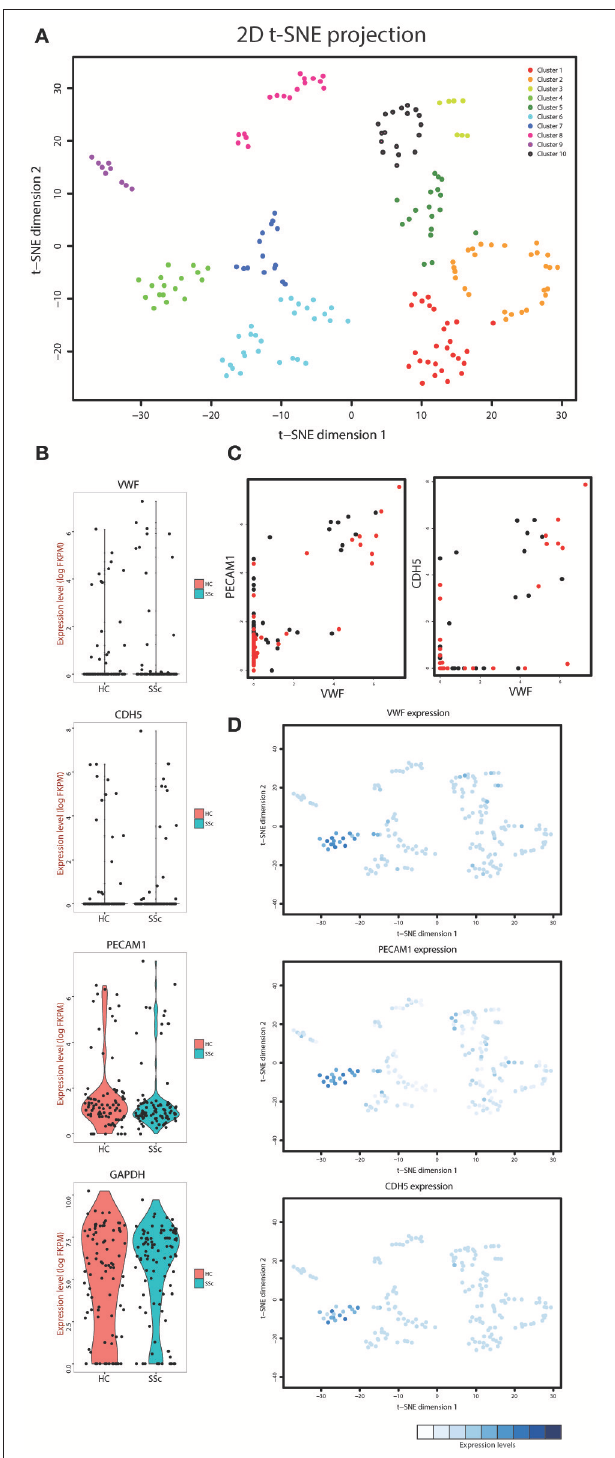
FIGURE 1 | (A) t-SNE analysis of the cells isolated from the systemic sclerosis (SSc) and healthy control (HC) skin. Overlaid is k-means clustering with a defined number of 10 clusters with every cluster represented by a different color. (B) Violin plots showing the expression levels and density of